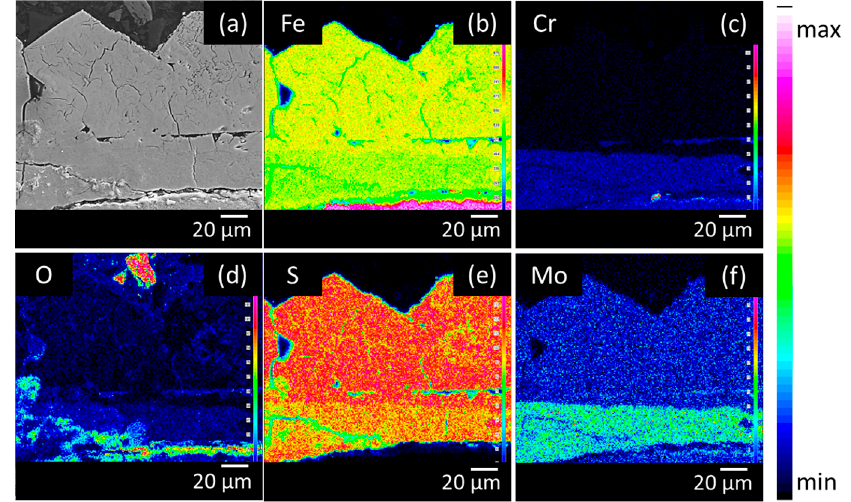
Figure 4. Cross-sectional Backscattered Electron (BSE) image ( a ) and elemental mappings of ( b ) Fe, ( c ) Cr, ( d ) O, ( e ) S and ( f ) Mo of the low Mo (A) material after 28 days of immersion in the H 2 S saturated test solution.